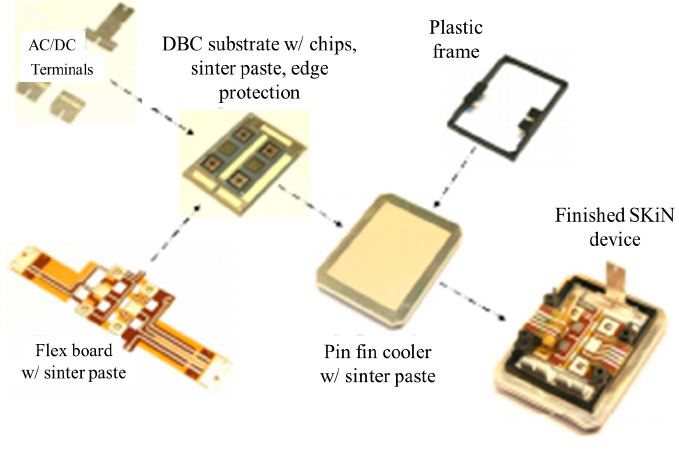
Figure 9. Exploded view of the SKiN module from Semikron [51]. Reprint with permission [4062740751911]; Copyright 2011, IEEE.